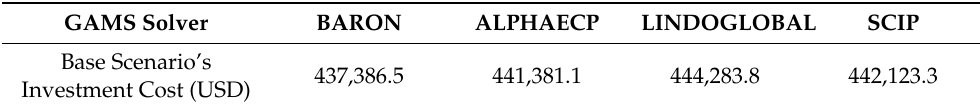
Table 4. Cost function value for different solvers in GAMS